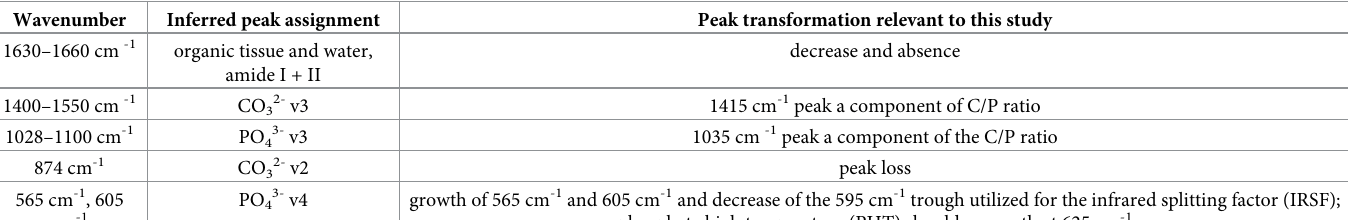
Table 3. FTIR-ATR wavenumbers associated with likely functional groups relevant to this study and the thermal alteration of bone. Wavenumber Inferred peak assignment Peak transformation relevant to this study 1630–1660 cm -1 organic tissue and water, amide I +